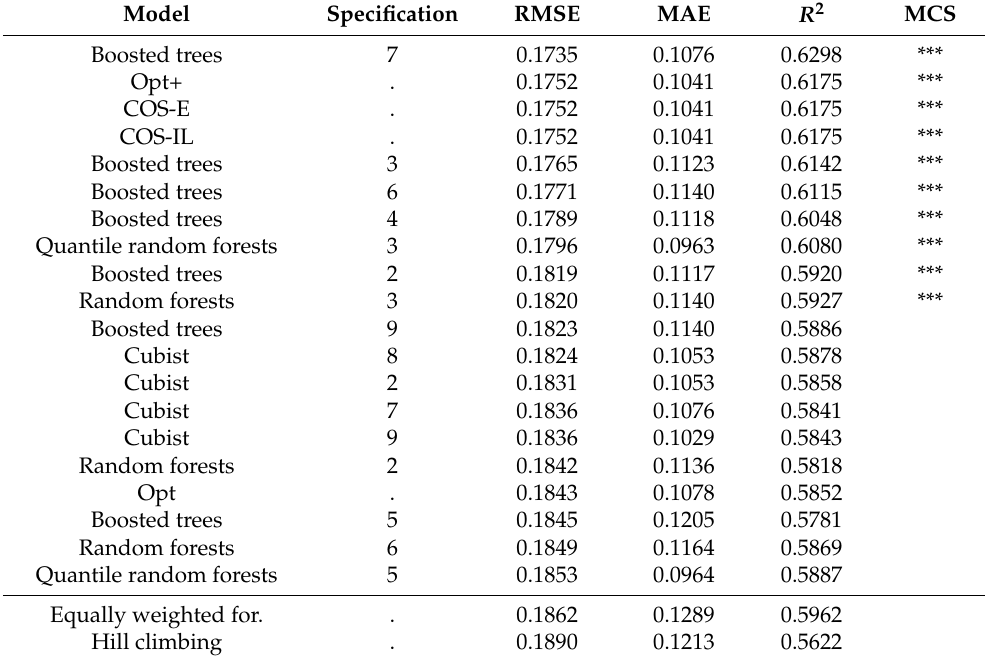
Table 13. Ranking of top 20 predictive frameworks according to out-of-sample root mean square error (RMSE) metrics across all specifications of the predictors set. The symbols *, ** and *** mark 1%, 5% and 10% significance levels of the model confidence test with L2 loss, respectively. For the sake of comparison, we also display the results corresponding to the equally weighted forecast and hill-climbing algorithm, despite ranking, respectively, 24th and 37th. Model Specification RMSE MAE R 2 MCS Boosted